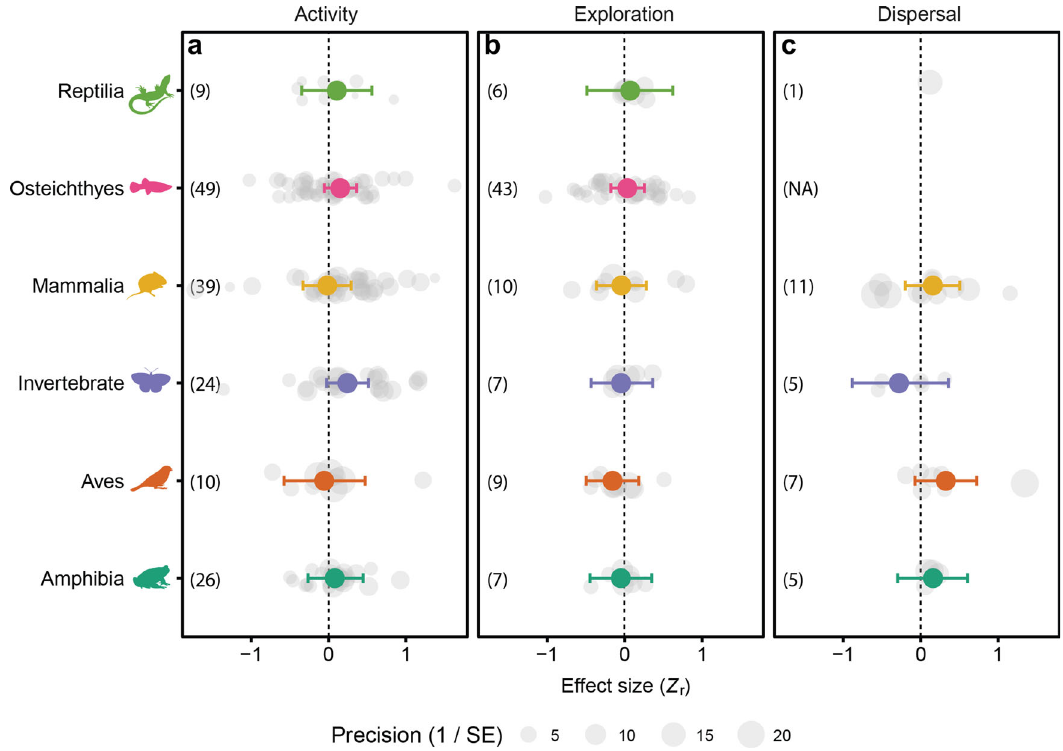
Fig. 4 Effects of physiological traits on the movement of different taxonomic groups. In this analysis, physiological traits were lumped together to determine their overall effect on a activity, b exploration and c dispersal of different taxa. Only taxa with more than fi ve effect sizes were analysed. Effects of physiological traits were generally weak (large overlap of credible intervals with zero), and the strongest effects were on the activity of fi sh (Osteichthyes) and invertebrates. Numbers in brackets indicate the number of effect sizes for each taxonomic group (NA = not available). Grey points represent individual effect size and the size of each symbol corresponds to study precision (inverse of standard error). Effect sizes ( Z r ) are estimates ±95% credible